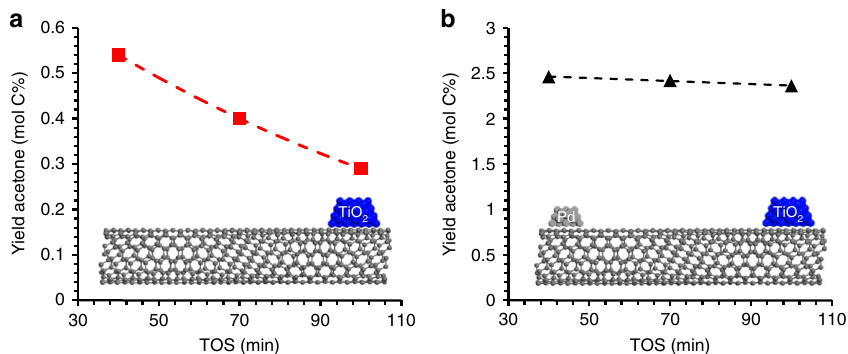
Fig. 3 Evidence for stable Ti 3 + sites under reaction conditions when Pd is on nanotube. a Acetone yield when co-feeding furfural and acetic acid over TiO 2 / CNT. b Acetone yield when co-feeding furfural and acetic acid under identical conditions over Pd/CNT/TiO 2 . Reactions were both measured at T = 400 fl ow as a function of time on stream (TOS) o C and P = 1 atm H 2